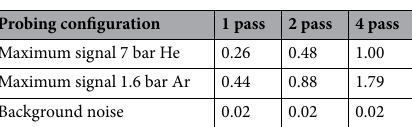
Table 1. Comparison of maximum phase shifts and background noise in radians for different probing